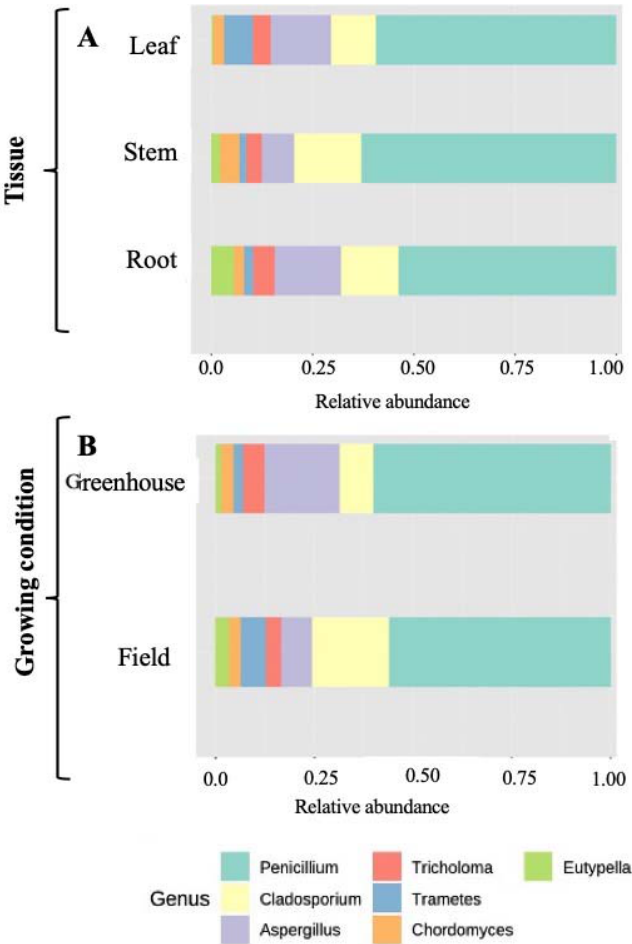
Figure 3. The endophytic community structure of fungal genera in different hairy vetch tissues ( A ) and growth conditions ( B ), showing their relative abundance. The result for each tissue is presented as the sum of that representative tissue, while for the growing condition it is the sum of all tissues.